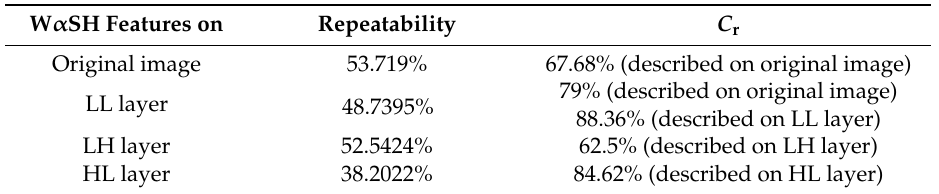
Table 1. Repeatability and correct matching rate of W α SH features on different image layer of the 5th image pair of Leuven.